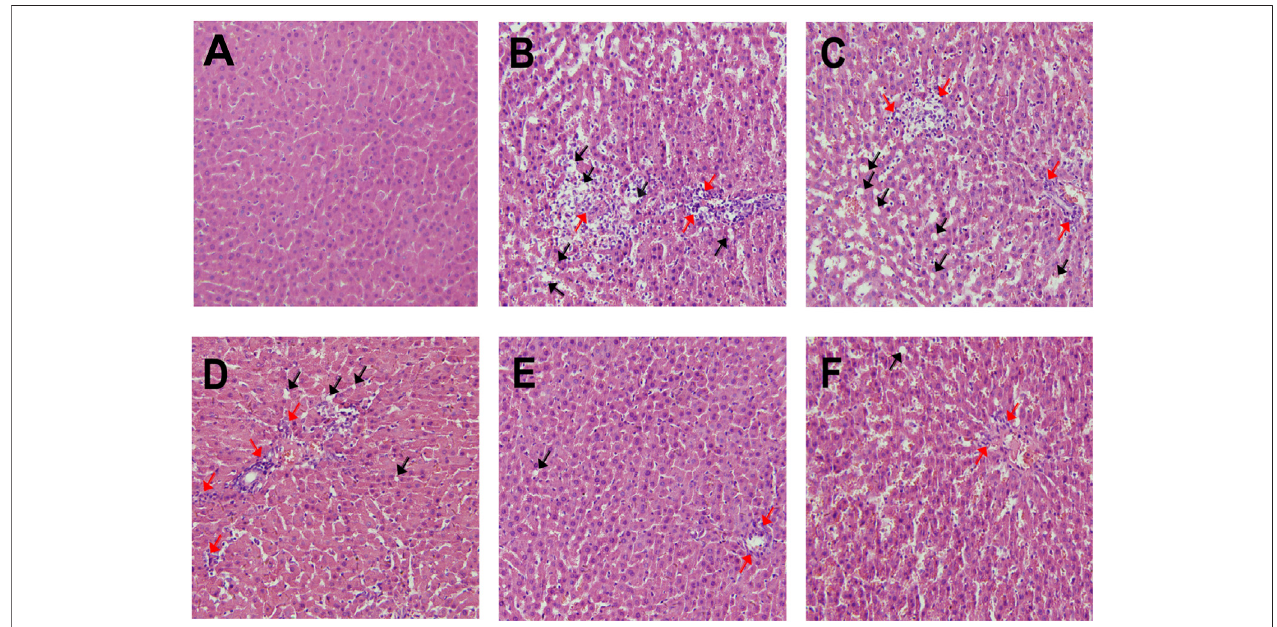
FIGURE9| EffectofGDDonliverhistologyinrats.RepresentativephotomicrographswithH&Estaining( × 200)revealhistopathologicalchangesofliver. (A) control group; (B) Copper-ladenmodelgroup; (C) low-dose GDD(0.65 g/kg/day); (D) medium-doseGDD(1.30 g/kg/day); (E) high-doseGDD (2.6 g/kg/day). (F) positivedrug treatment (PA, 0.048 g/kg/day). Cytoplasmic vacuolations (black arrow), hepatocellular necrosis (red arrow).